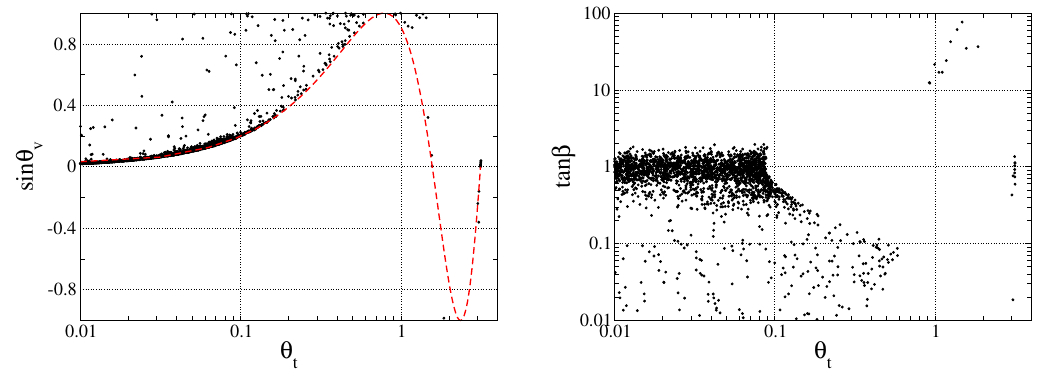
Figure 1 . Correlations between θ t and sin θ v (left) as well as θ t and tan β (right). In the left plot, the red dashed curve represents sin 2 θ t